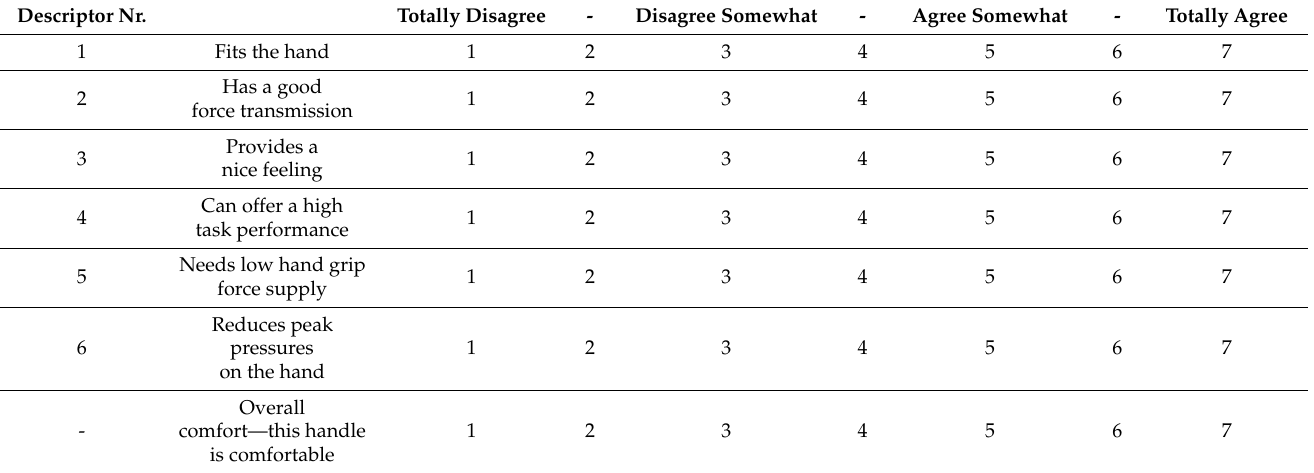
Table 1. Subjective comfort rating questionnaire.